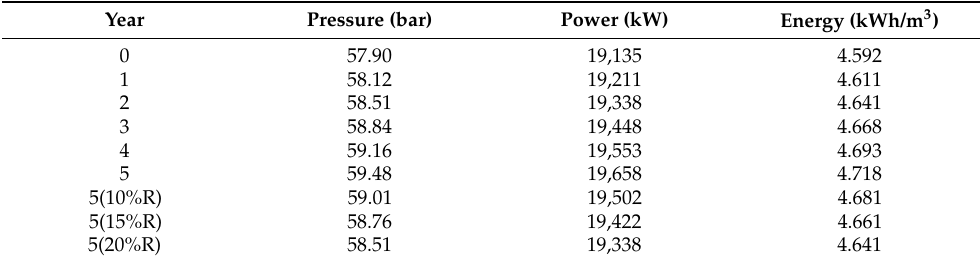
Table 4. Pressure, Power, and Energy consumption at 22 ◦ C.